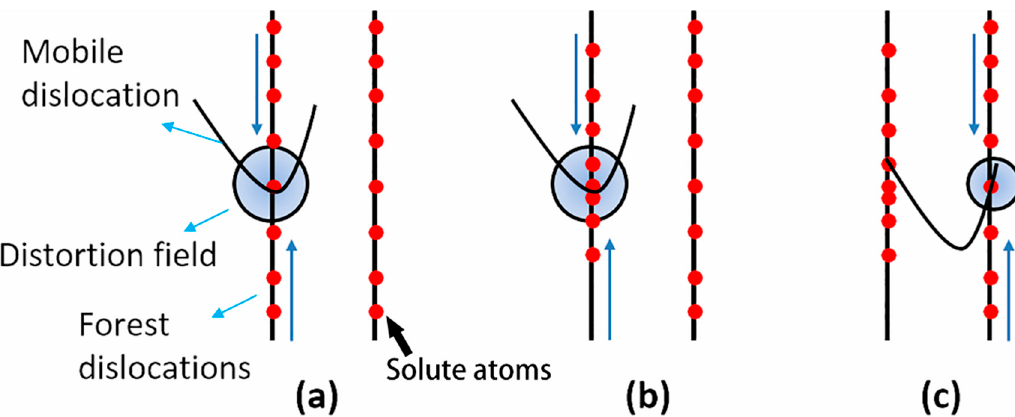
Figure 10. The evolution of the serrated flow. ( a ) Mobile dislocations are hindered by forest dislocations; ( b ) solute atoms (red dots) move along the dislocation line toward the mobile dislocation; ( c ) mobile dislocations are free from pinning.